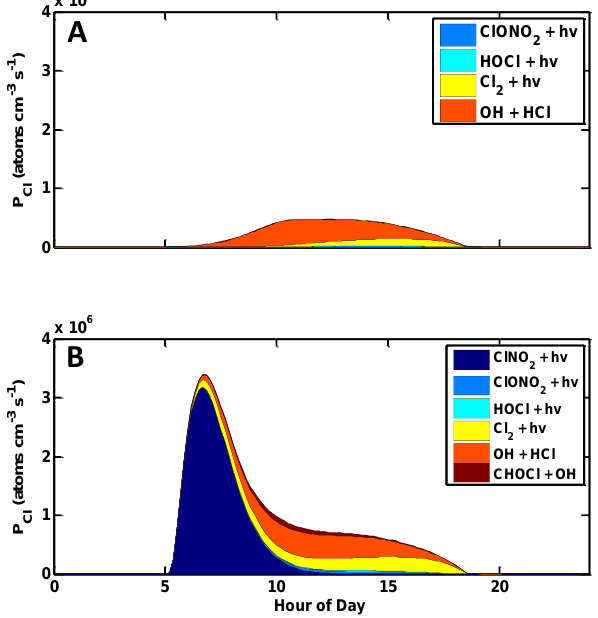
Fig. 2. Model calculated Cl · production channels (A) without ClNO 2 formation and (B) with ClNO 2